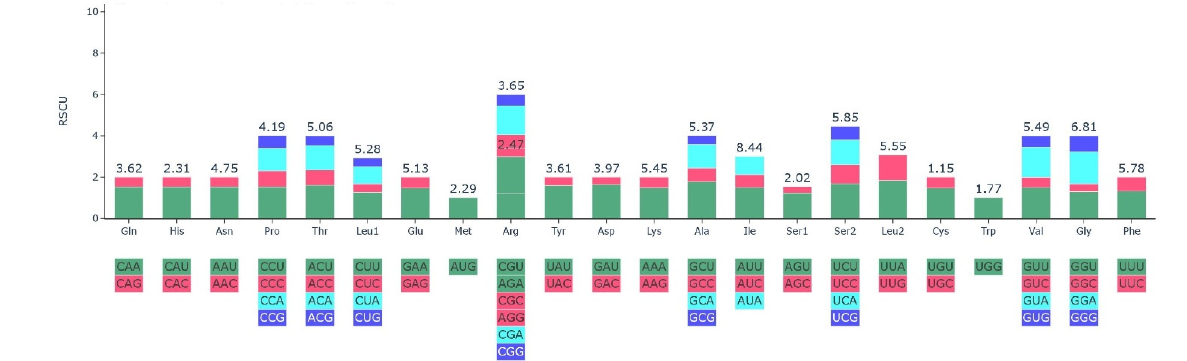
Figure 2. The 20 amino acids and stop codons’ relative synonymous codon usage (RSCU) in the chloroplast genome of H. forskaolii’s protein-coding